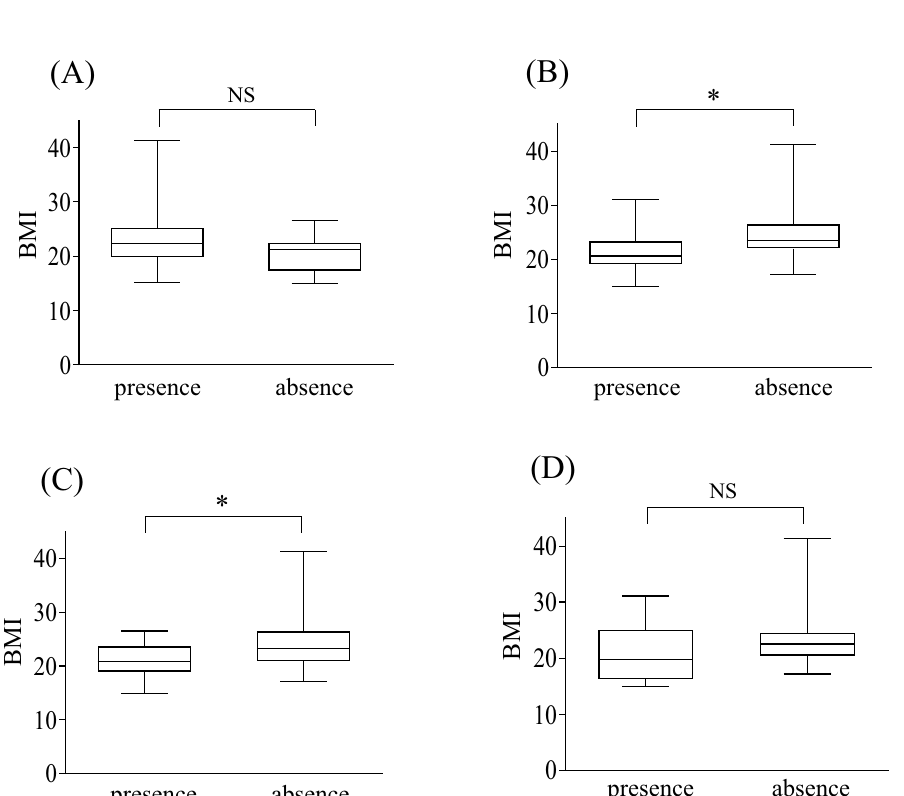
Figure 2. Comparison between body mass index (BMI) of patients with presence and absence of local findings in periprosthetic hip infection (PHI). The patients with swelling or hyperthermia had significantly lower BMI than those without them in PHI. Pain ( A ), swelling ( B ), hyperthermia ( C ), and sinus tract ( D ) *p < 0.05, NS no significant